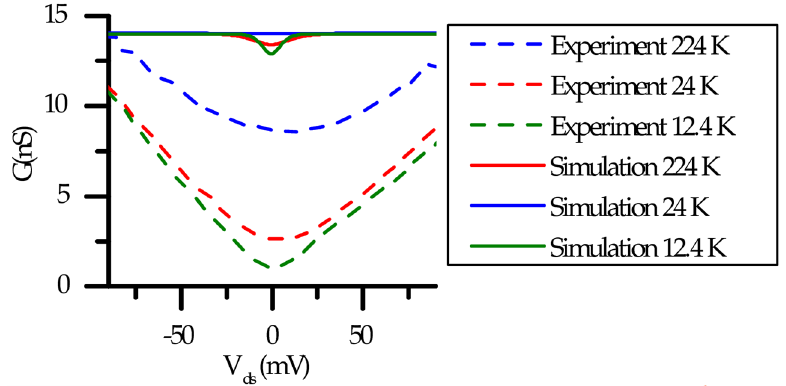
Figure 8. Evidence of parasitic oxide: Experimental and simulated G ( V ds ) dependences for an untreated Ni ‐ SiO 2 ‐ Ni SET at different temperatures.